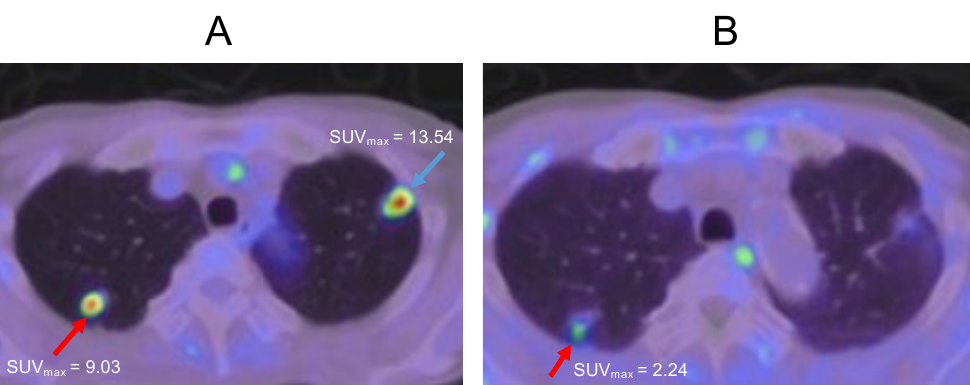
Figure 3. Lung tumors at both sides of the lung apex. ( A ): FDG ‐ PET imaging. ( B ): MET ‐ PET imaging. The red arrows indicate cancer, and the blue arrow indicates granuloma.